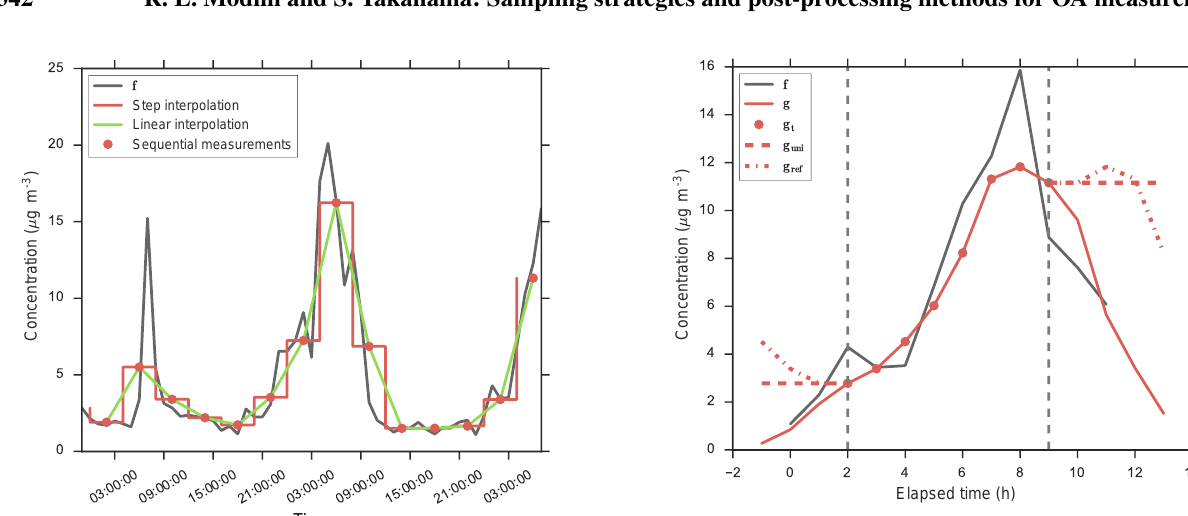
Figure 3. An illustrative example of interpolation between sequen- tial samples. An original time series f of HOA concentrations, and the time series resulting from step (red) and linear (yellow) interpo- lation between successive sequential samples, which are indicated by the circle markers.